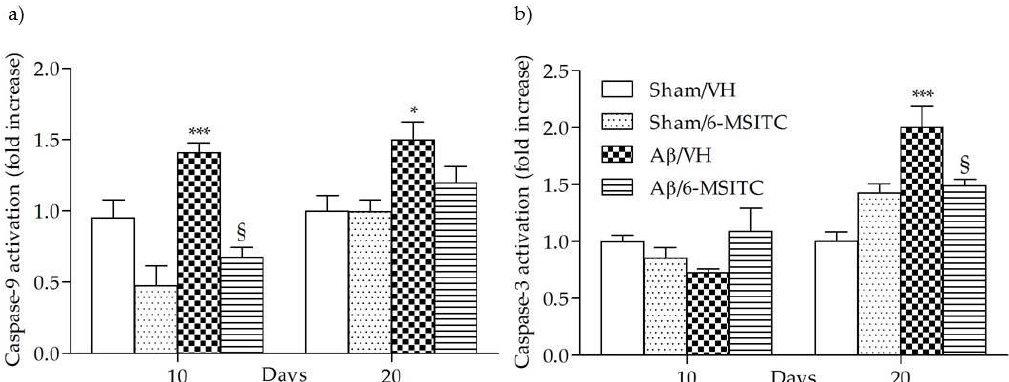
Figure 5. Effects of 6-MSITC (5 mg/kg) on caspase-9 ( a ) and -3 ( b ) activations 10 and 20 days after A β 1-42 O injection. Caspase-9 and -3 activations were determined using a specific chromogenic substrate in hippocampal samples. Values are expressed as mean of fold increase ± SEM ( n = 10) of optical density (OD) of each experimental group compared to the Sham/VH group ( a : * p < 0.05 and *** p < 0.001 vs. sham groups, § p < 0.05 vs. A β /VH; b : *** p < 0.001 vs. Sham/VH, § p < 0.05 vs. A β /VH; ANOVA, post hoc test